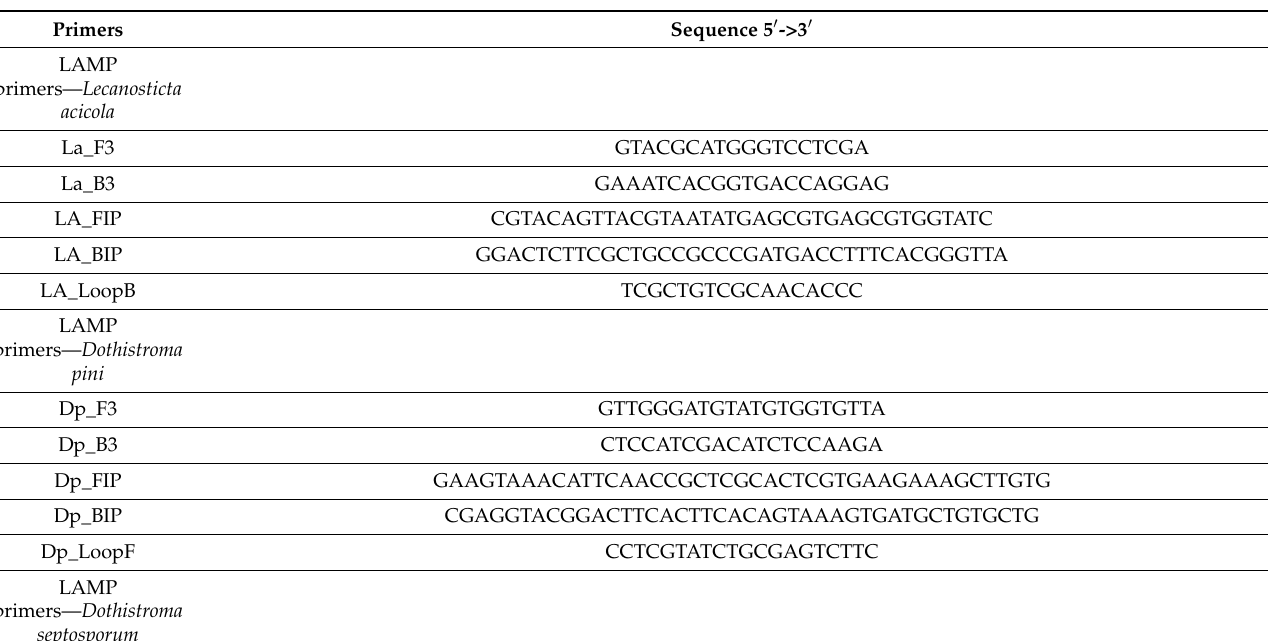
Table 3. Primers and probes used for the detection of Lecanosticta acicola , Dothistroma pini and D. septosporum using LAMP assays.